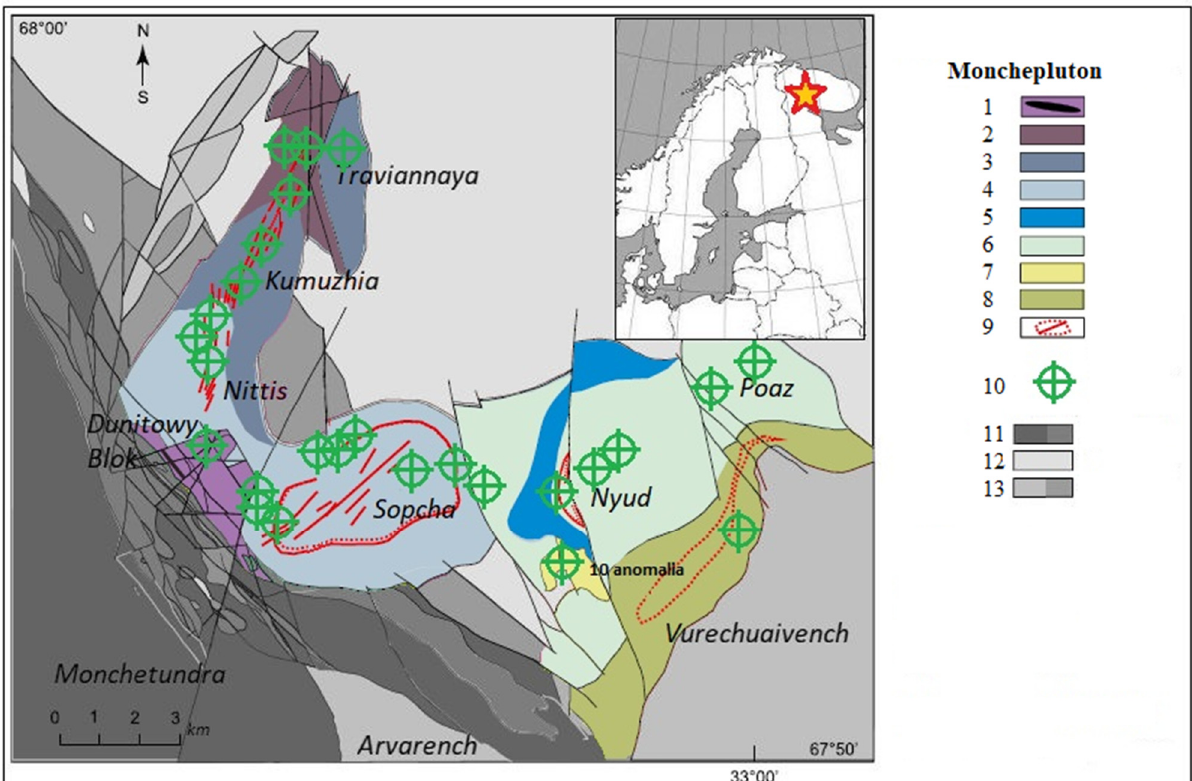
Figure 1. Schematic sketch of the Monchepluton intrusion (according to Mitrofanov and Smolkin [25], simplified by the author) with the location of the tested samples. Legend: (1) dunite, chromitite; (2) harzburgite; (3) other peridotites; (4) orthopyroxenite; (5) norite, olivine norite; (6) gabbronorite; (7) gabbro; (8) anorthosite; (9) sulfide ore mineralization; (10) samples localization; (11) rocks of the Monchetudra massif; (12) rocks of the Imandra – Varzuga Belt; (13) rocks of the Kola Series. The red-orange star in the map inset, symbolizes the location of the intrusion on the Scandinavian background.